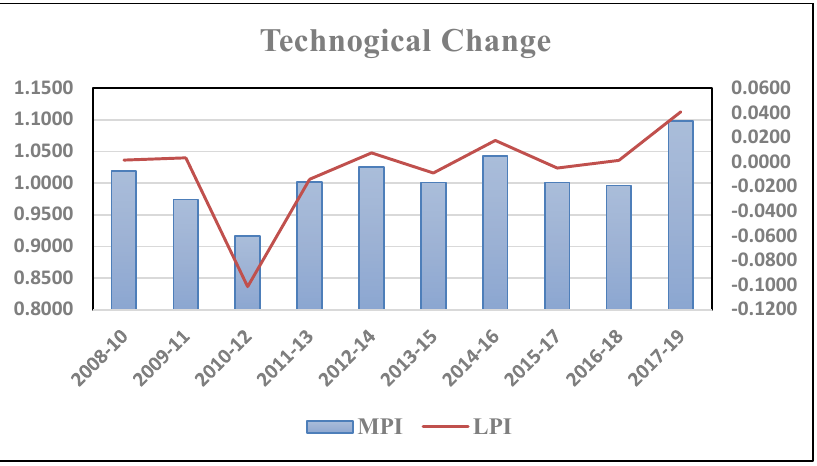
Fig. 3 . Malmquist and Luenberger Technological Change in